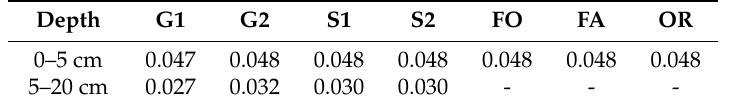
Note: G1 represents introduced grassland; G2 represents natural grassland; S1 represents introduced shrubland; S2 represents natural shrubland; FO represents forest; FA represents farmland; OR represents orchard.